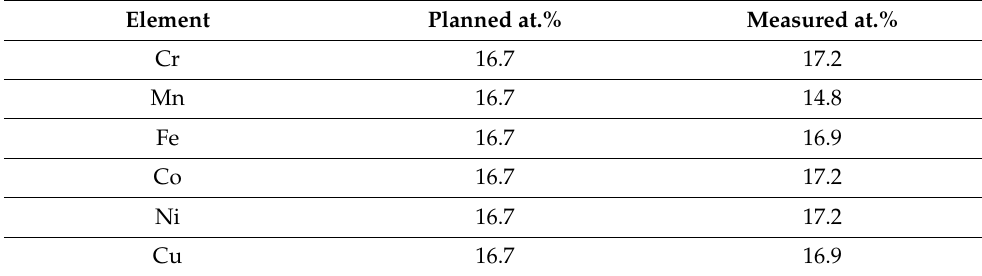
Table 4. Nominal (planned) versus actual (measured) compositions of the cast ingot. Element Planned at. %